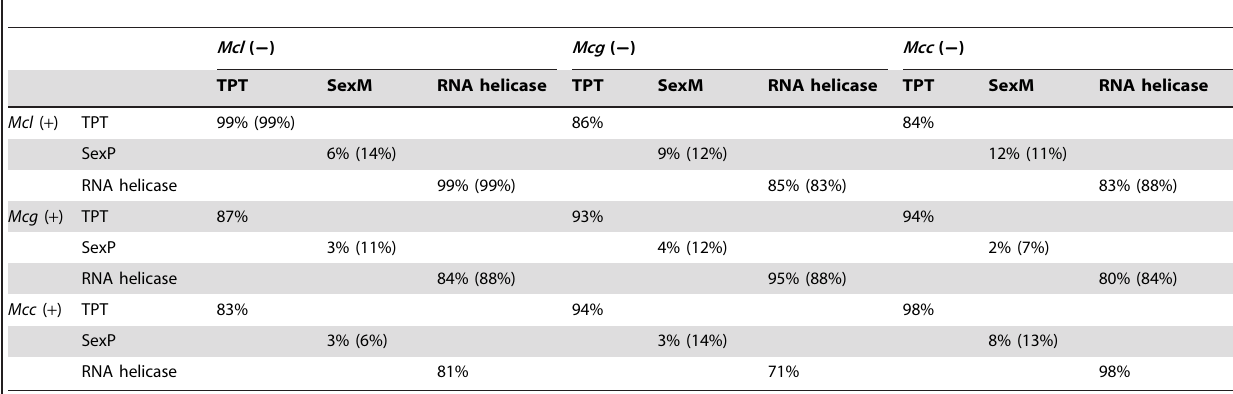
Table 4. DNA and deduced protein sequence comparison between three subspecies.